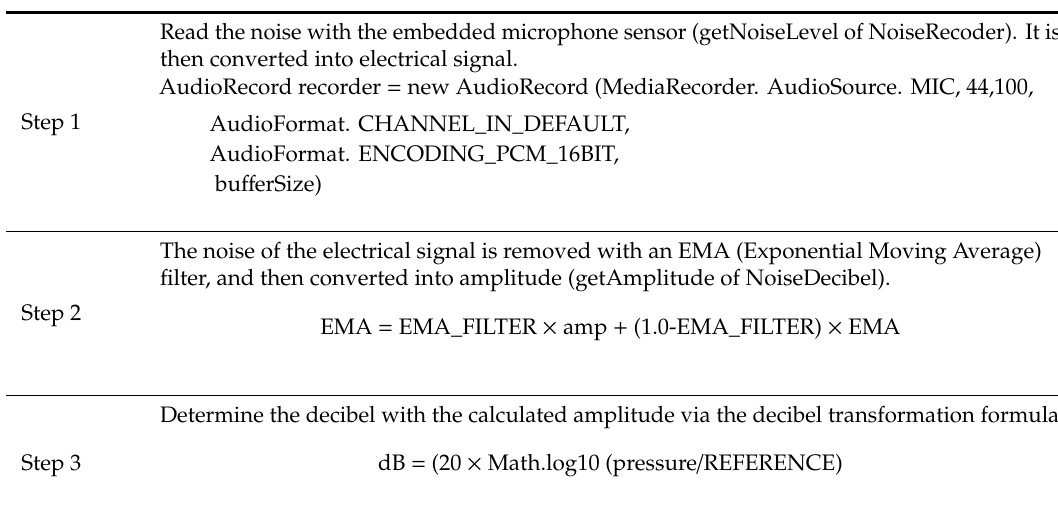
Table 1. Noise level measuring